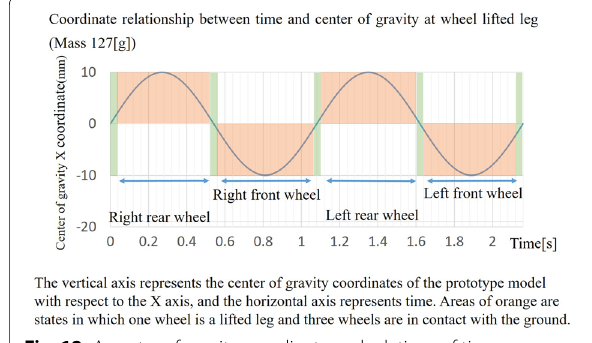
Fig. 12 A center of gravity coordinate and relations of